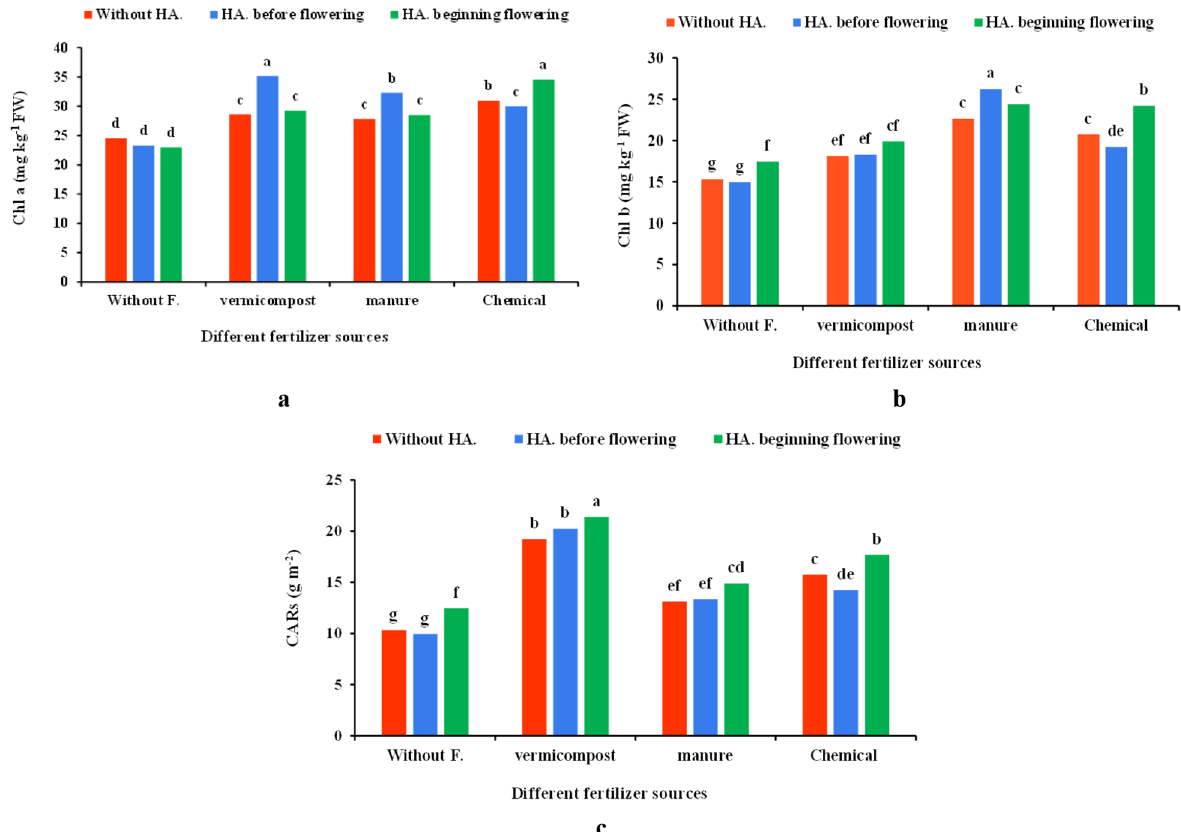
Figure 3. Effect of different fertilizer sources × humic acid (HA) treatments on chlorophyll a (Chl a ) ( a ), chlorophyll b (Chl b ) ( b ), and carotenoids (CARs) ( c ) of the coriander plant. Different letters indicate significant differences according to LSD test P < 0.05 (average of two